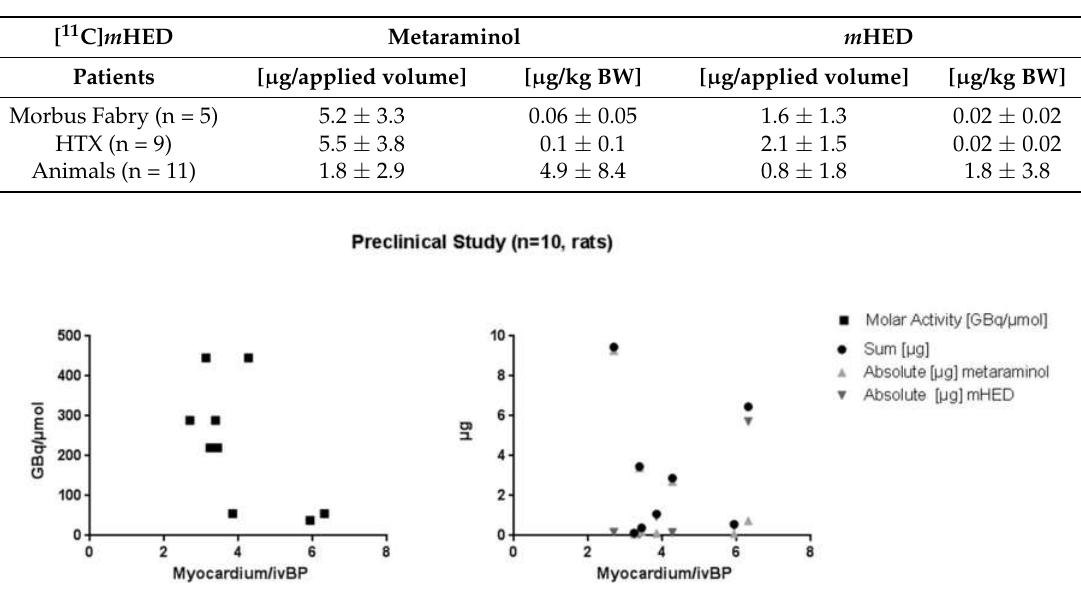
Figure 1. Correlation of the myocardium/intra-ventricular blood pool ratio and the molar activity, the mass of residual precursor and non-labelled m HED, as well as the sum of both.